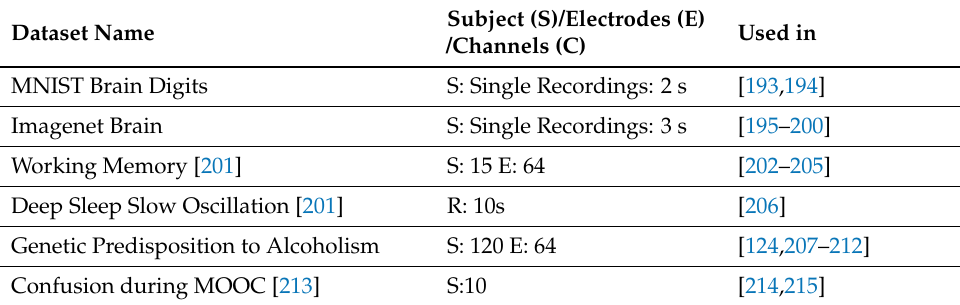
Table 5. A table of different types of miscellaneous datasets.